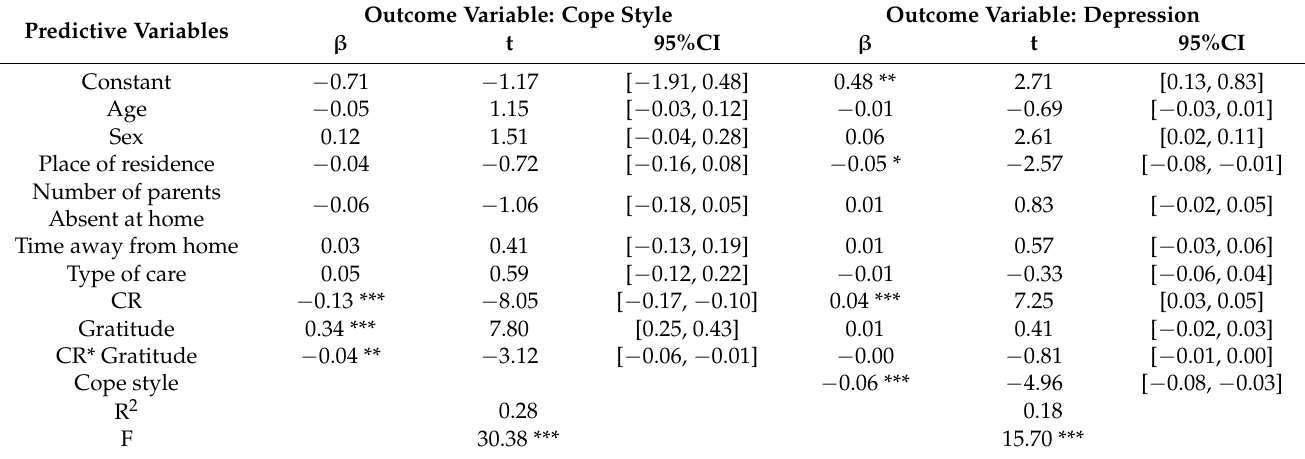
Table 2. Test for moderating mediating effects of CR on